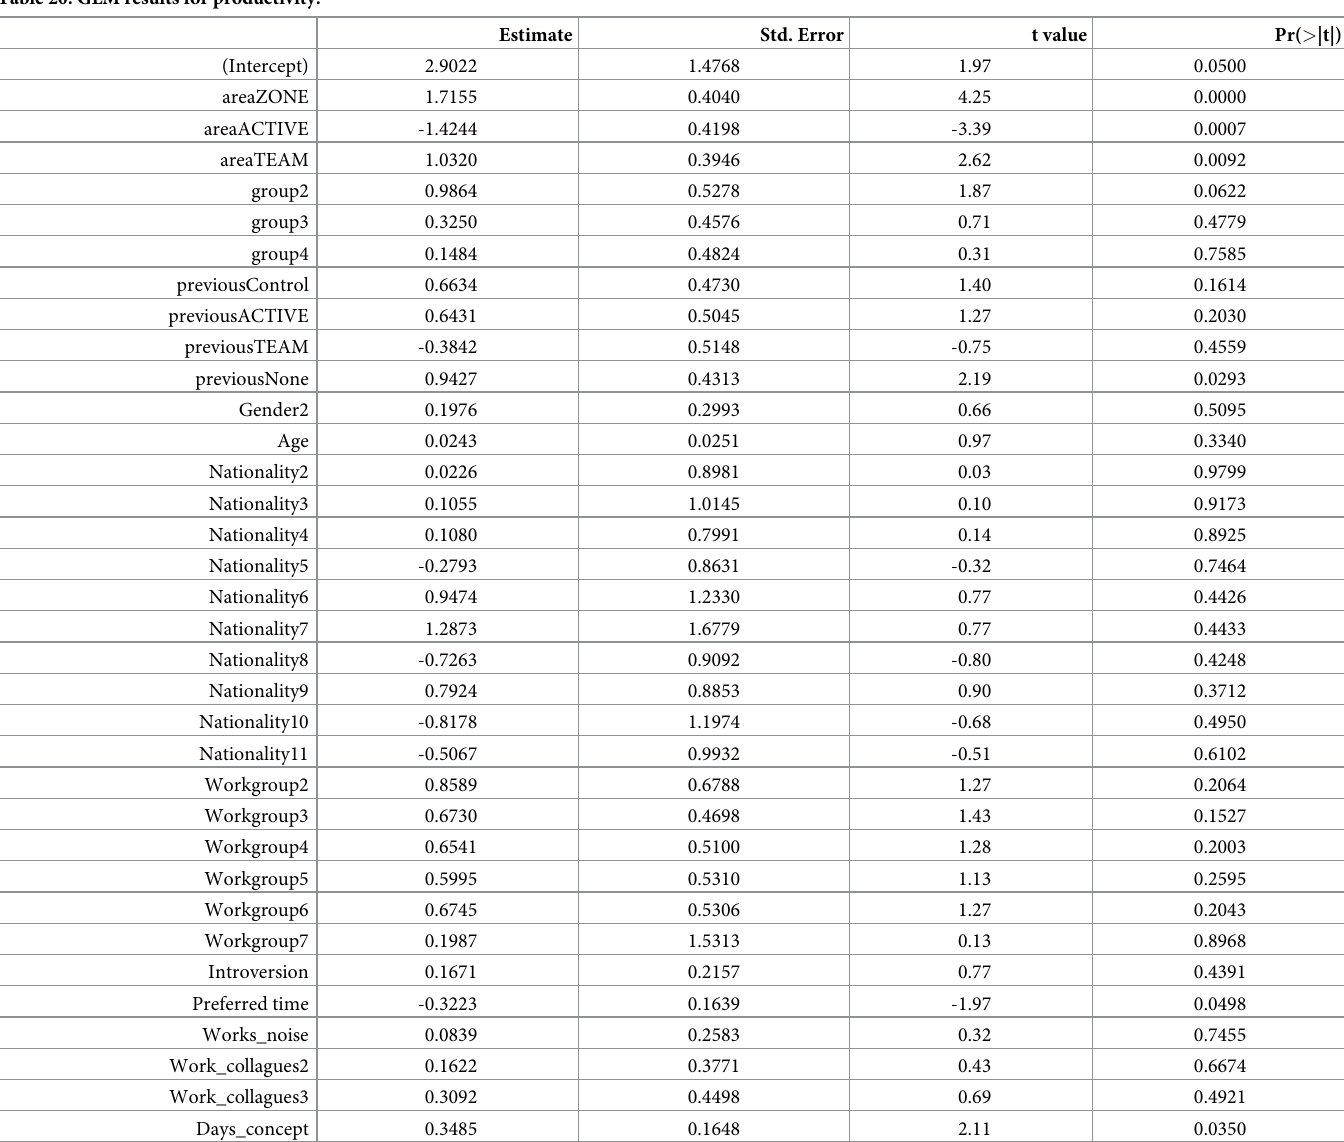
Table 20. GLM results for